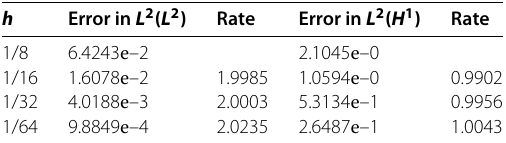
Table 3 The errors and convergence rates of u – u hk in the L 2 ( L 2 ) and L 2 ( H 1 ) norms concerning h h Error in L 2 ( L 2 ) Rate Error in L 2 ( H 1